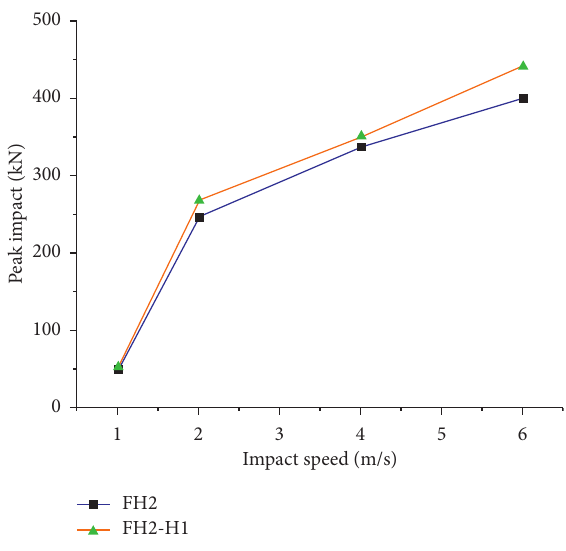
Figure 13: Speed-impact peak relationship.